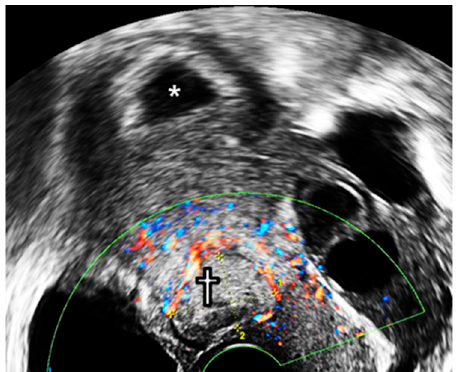
Figure 3. Transvaginal ultrasonography examination at 7 +1 GW. *—intrauterine gestational sac; †—RGT; CSP—cesarean scar pregnancy; GW—gestational weeks; RGT—remnant gestational tissue.